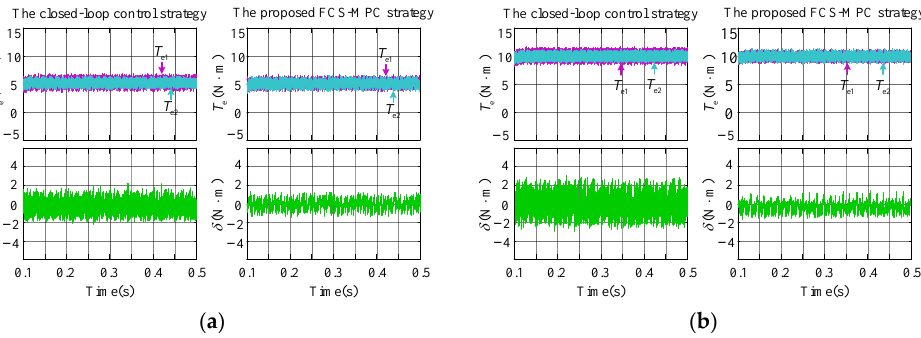
Figure 6. Simulation results of the different loads: ( a ) load torque is 10N m and ( b ) load torque is 20N